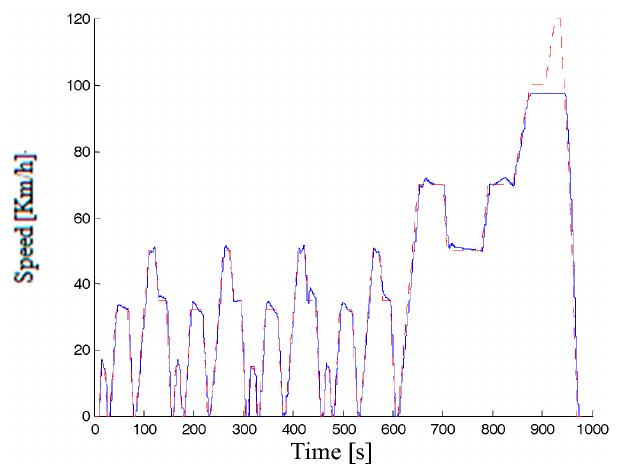
Figure 12. Actual speed under NEDC cycle condition.